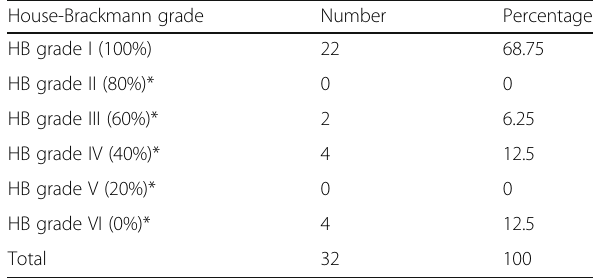
Table 2 Postoperative facial nerve functional